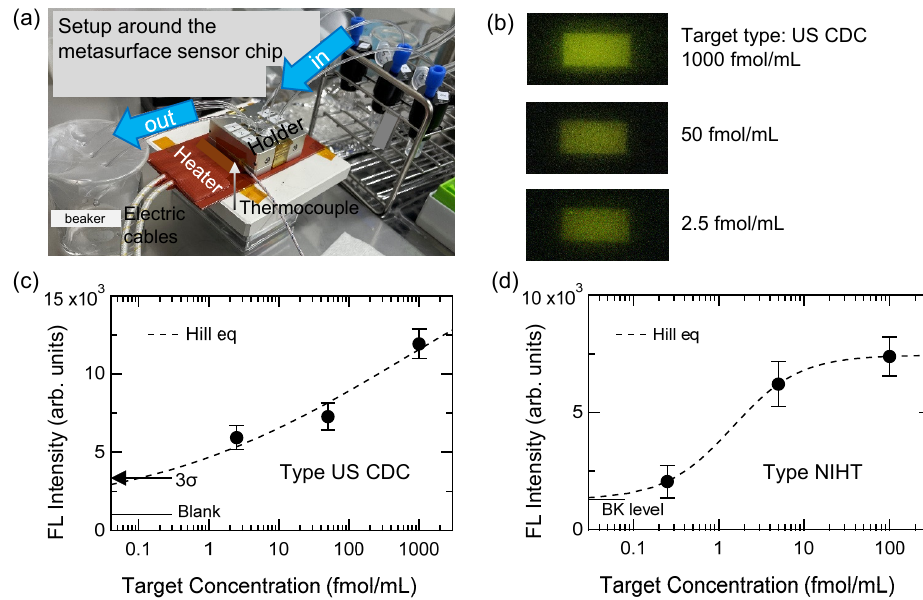
Figure 2. ( a ) Experimental setup around the holder setting metasurface sensor chip. The holder was heated in a feedback manner, as described in the text. ( b ) FL images from the immobilized FL-labeled DNAs (type: US CDC, Table 1). The rectangular metasurface area was 1.2 × 0.6 mm 2 in common. ( c , d ) Detection curves of modeled SARS-CoV-2 targets, types of US CDC and NIHT, respectively. Black dashed curves are fitted curves using the Hill equation (Equation (2)). Horizontal bar in subfigure ( c ) indicates target blank (or zero signal) level. An arrow in subfigure ( c ) indicates an estimated LOD level at 3 σ ( σ : standard deviation) from the blank level. Horizontal bar in subfigure ( d ) indicates background (BK) level, which is equal to y 0 in Equation